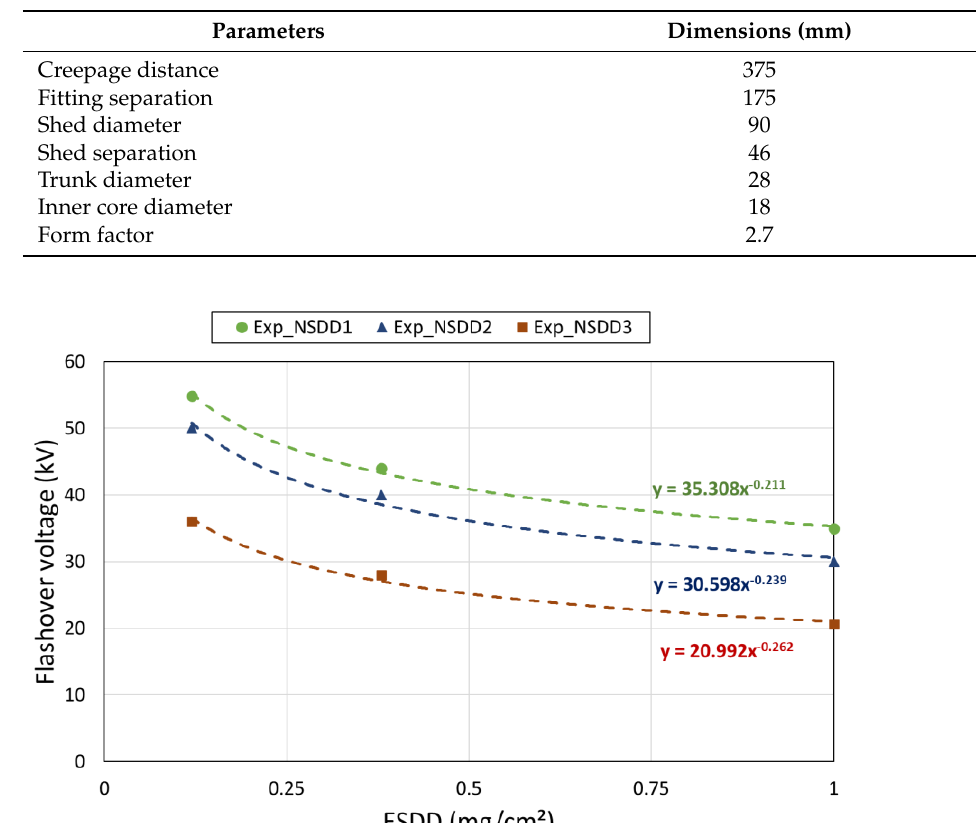
Table 2. Dimensions of tested insulators.